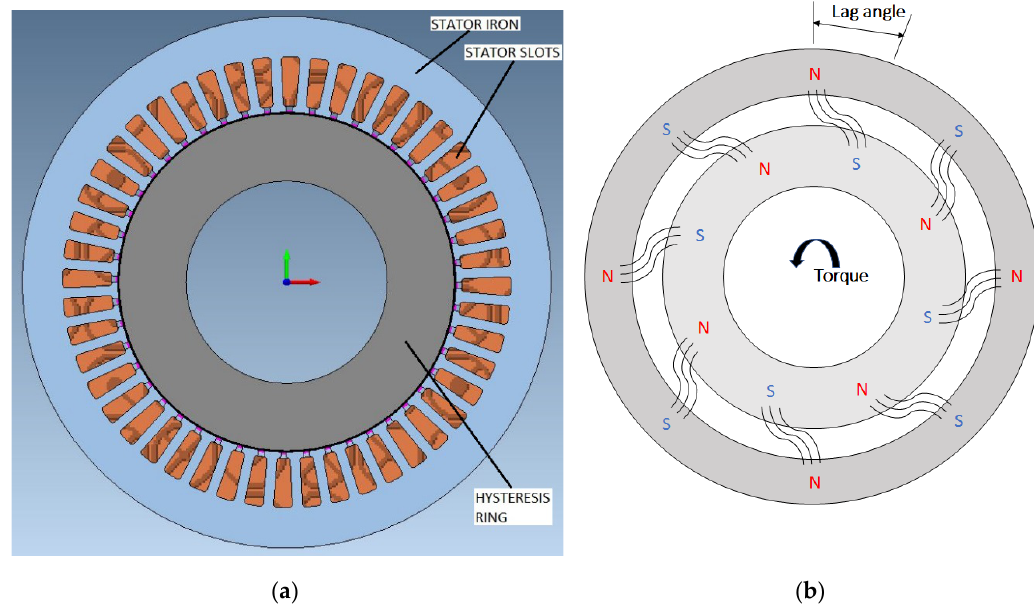
Figure 2. ( a ) Typical Hysteresis motor; ( b ) torque production principle.